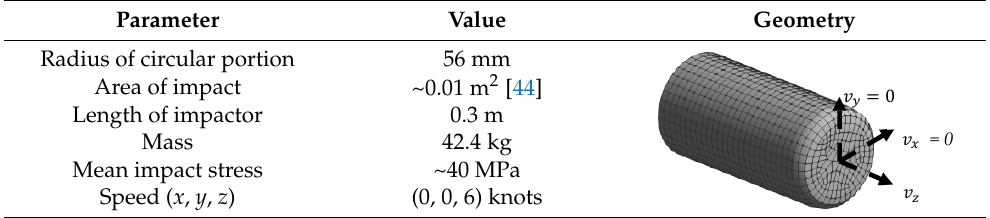
Table 3. Geometry details of impactor.